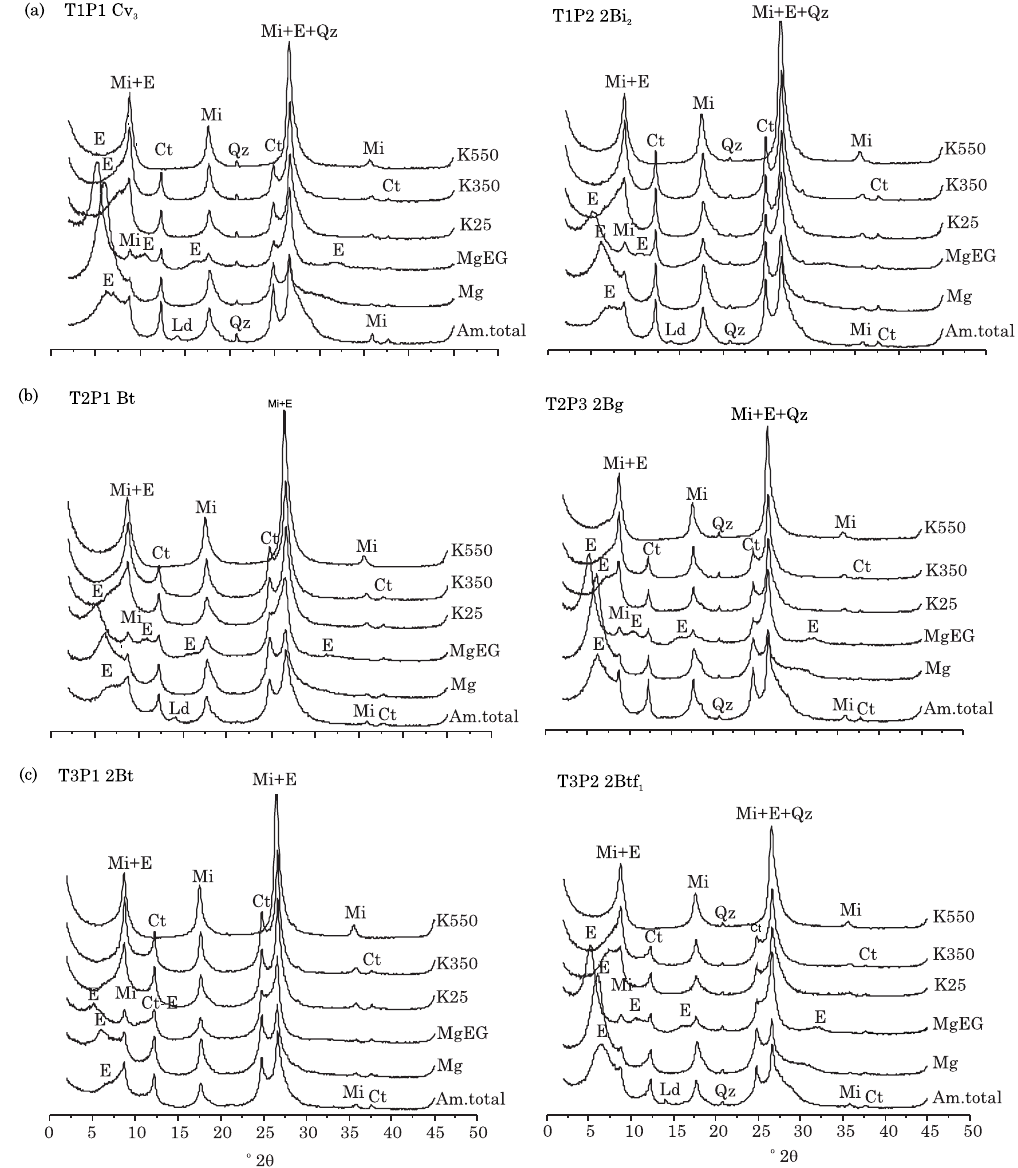
Figure 2. X-ray diffractograms of the clay fraction of the horizons of the T1 (a), T2 (b) and T3 (c) toposequences. E: smectite, Mi: mica, Ct: kaolinite, Ct-E: interlayered kaolinite-smectite, Ld: lepidocrocite, Qz: